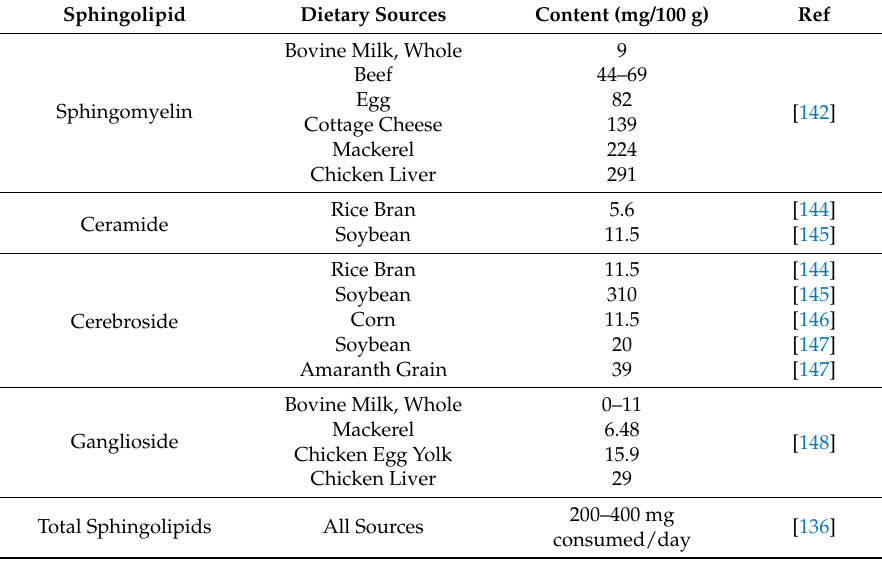
Table 1. Sphingolipid content of